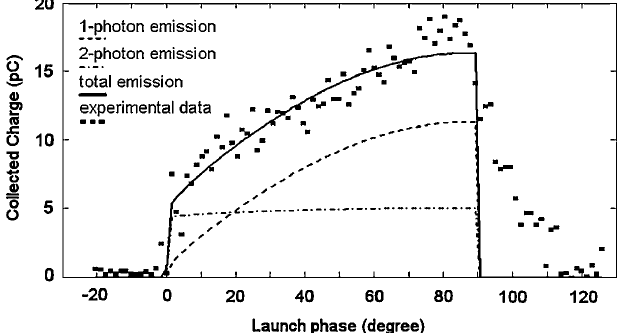
FIG. 4. Electron bunch charge vs launch phase: in the graph are reported the experimental data, and the emitted charge simulated by considering both one and two photoemission